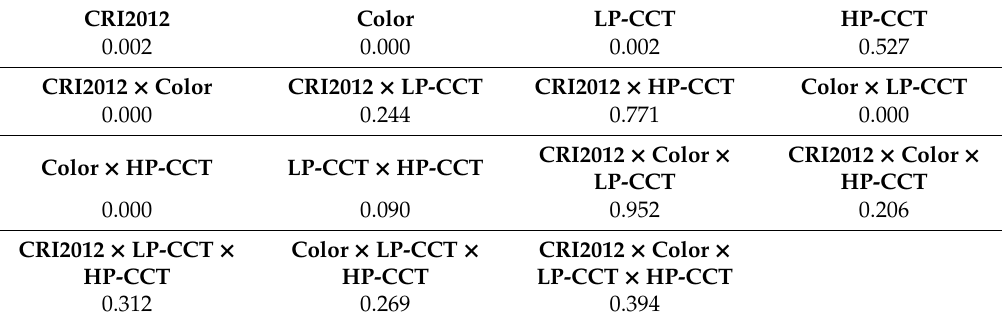
Table 2. P value of significance analysis for the above